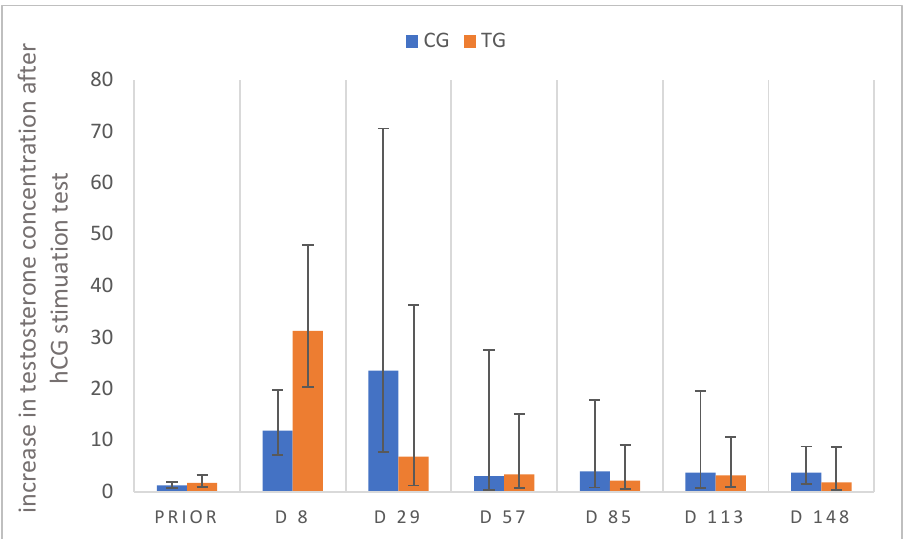
Figure 11. Relative increase in plasma testosterone concentrations 60 min after hCG stimulation; testosterone values pre-stimulation are considered as 1, relative increase from pre- to post-stimulation is presented for study day PRIOR (day 11 prior to treatment), D8, D29, D57, D85, D113, D148 animals treated with a 4.7 mg deslorelin implant (TG, n = 7) and saline-treated control animals (CG, n = 3). Results are given as geometric mean x ̅ g (DF). “Prior” indicates “prior to treatment”.